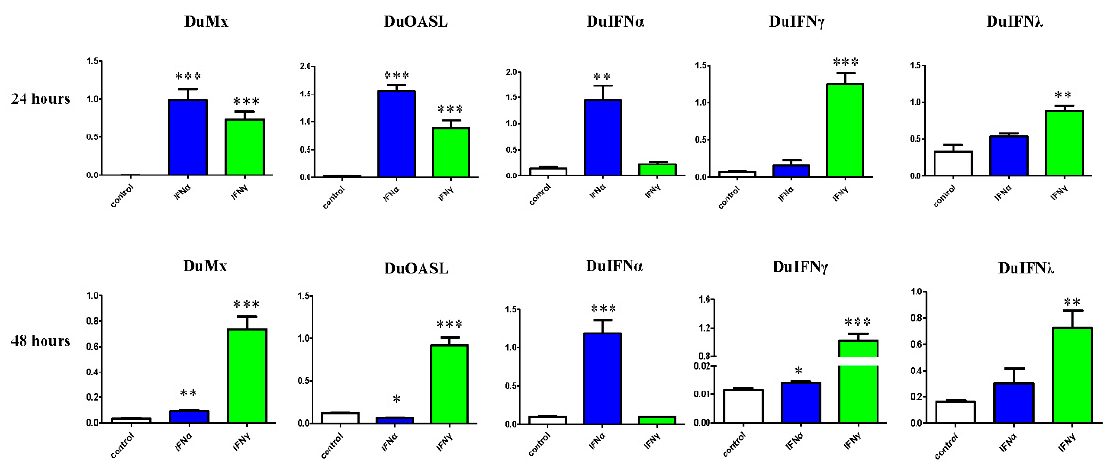
Figure 6. Detection of duck Mx (duMx), duck OASL (duOASL), duck IFN α (duIFN α ), duck IFN γ (duIFN γ ), and duck IFN λ (duIFN λ ) gene expression levels in DEFs. Cells were collected at 24 h and 48 h after the goose IFN α (goIFN α ) and goose IFN γ (goIFN γ ) protein pretreatment (60 µg/well). The mRNA levels were measured by real time PCR and are expressed relative to β -actin mRNA. Duck embryo fibroblast (DEF) cells were seeded in 6-well plates and then pretreated with by IFN α or IFN γ protein for 12 h. Symbols show four replicate experiments. The results shown are the mean ± SEM of four samples. Significant differences compared with cells without IFN treatment are denoted by * p < 0.05; ** p < 0.01 and *** p < 0.001.